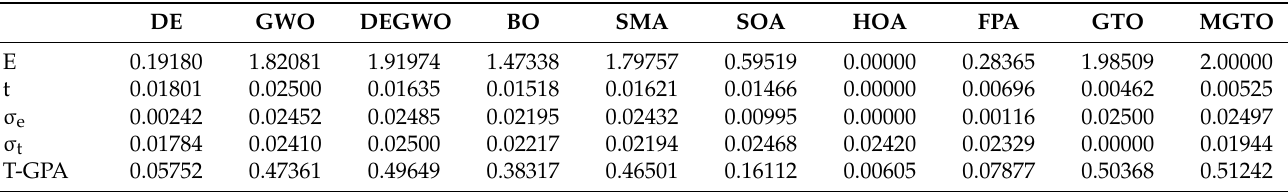
Table 9. Comparison under T-GPA on test case 1.